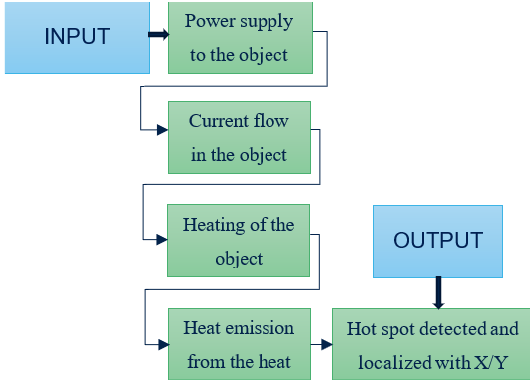
Fig. 1 . The process of thermal